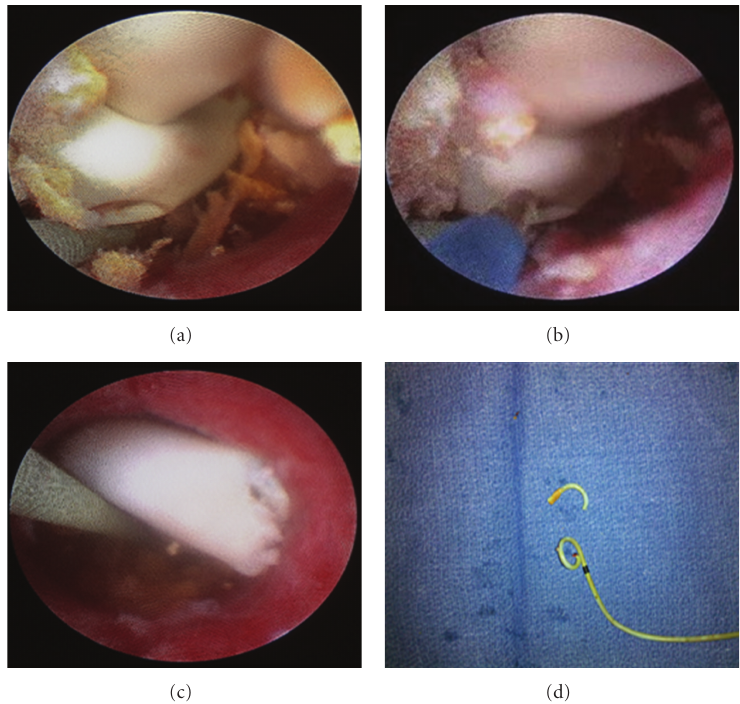
Figure 2: Summarizes the stages of the procedure; (a) The completely tightened stent knot as visualized during ureteroscopy, (b) The tip of the 365um laser fiber directed to the knot, (c) The residual proximal fragment after extraction of the stent, (d) The two stent fragments after complete